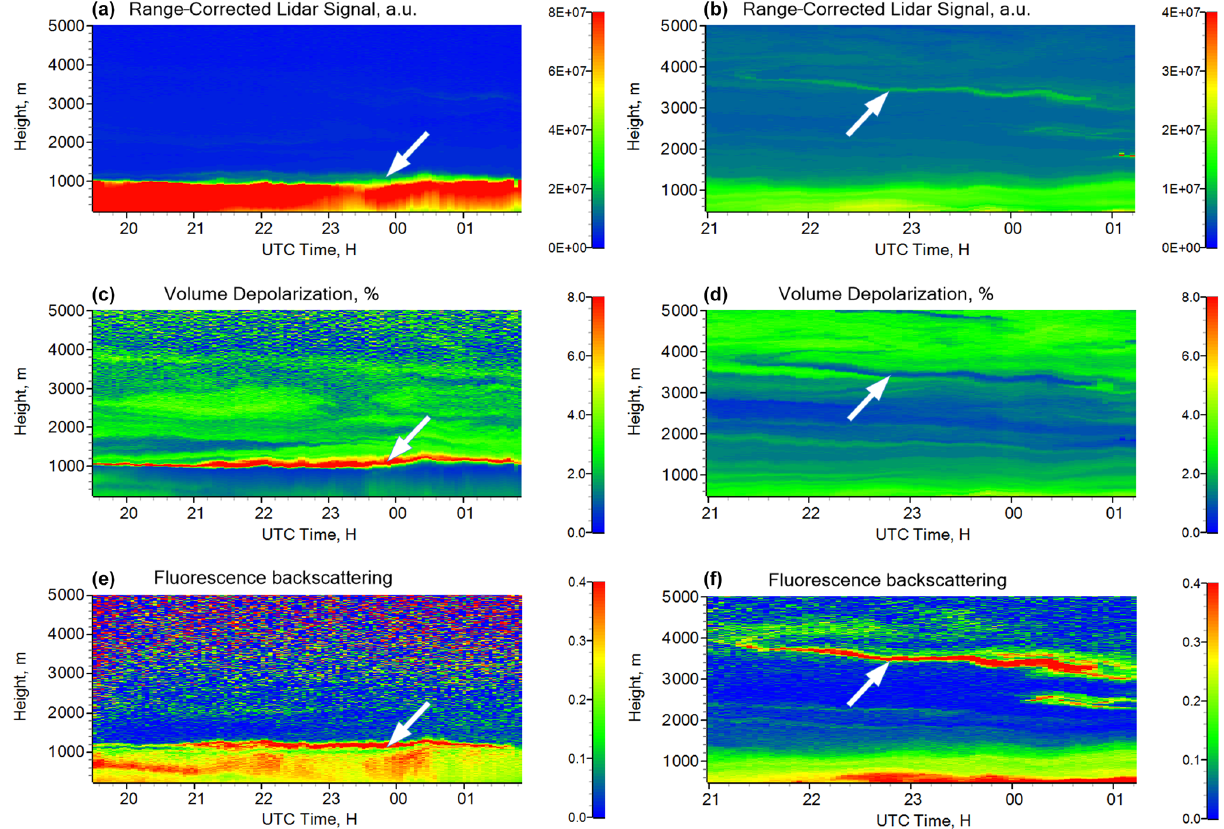
Figure 12. Range-corrected lidar signal at 1064nm, volume depolarization ratio δ v 10 − 4 Mm − 1 sr − 1 ) measured on 13–14 April (a, c, e) and 26–27 May 2020 (b, d, f) . Arrows point to the fluorescent